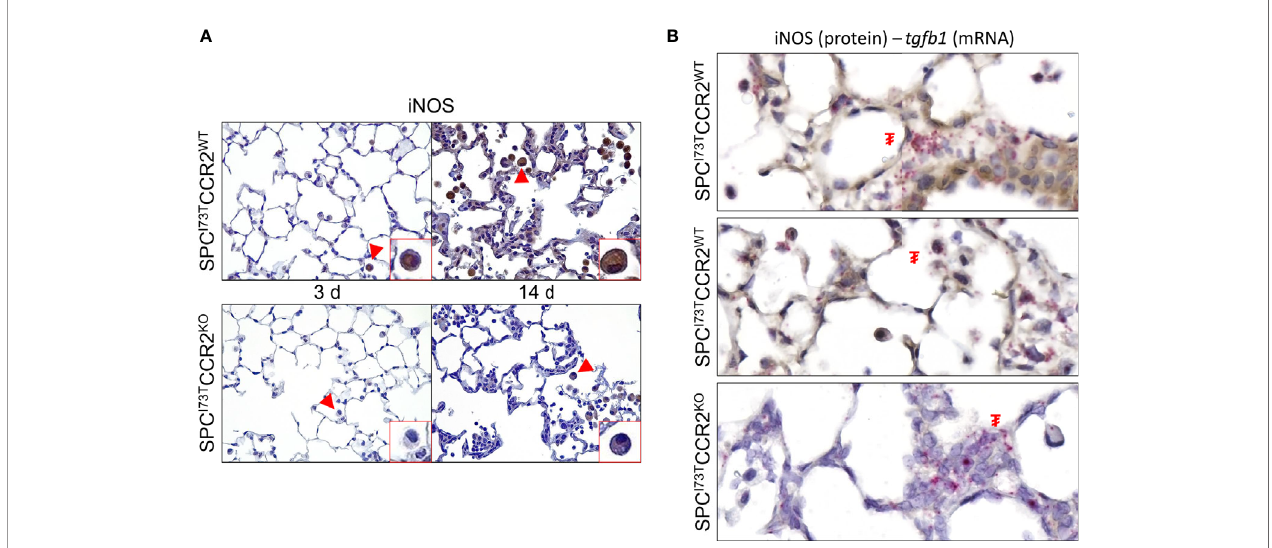
FIGURE 9 | Effects of CCR2 monocyte ablation on pro-in fl ammatory activation following SP-C I73T induced injury. Histochemical analysis alone or in combination with in situ hybridization of SP-C I73T CCR2 WT and SP-C I73T CCR2 KO lung following SP-C I73T induced injury. Sections were immunostained with antibody to (A) iNOS. Binding was visualized using a Vectastain kit. Insets show magni fi ed cells; box color matches that of arrowhead. Original magni fi cation, 400x; inset magni fi cation, 750x. (B) IHC + in situ hybridization (iNOS + Tgfb1) . mRNA visualization is shown in pink. Protein expression was visualized using a DAB Vectastain kit (brown). Arrowheads indicate cells expressing the receptor. ₮ indicate mRNA expressing cells. Original magni fi cation, 1000x. Representative region is shown (N = 3).